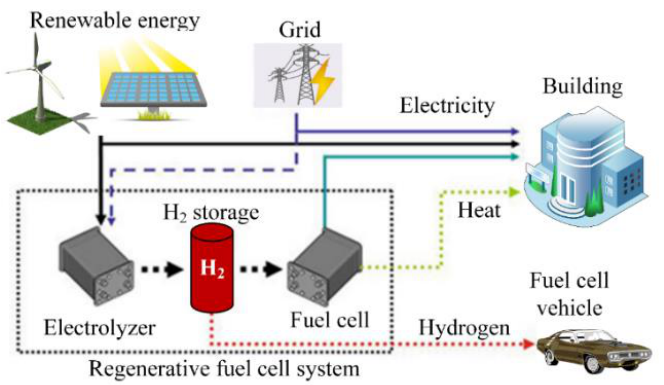
Figure 73. Renewable energy storage using a regenerative fuel cell (RFC) system for a building and vehicle [217].